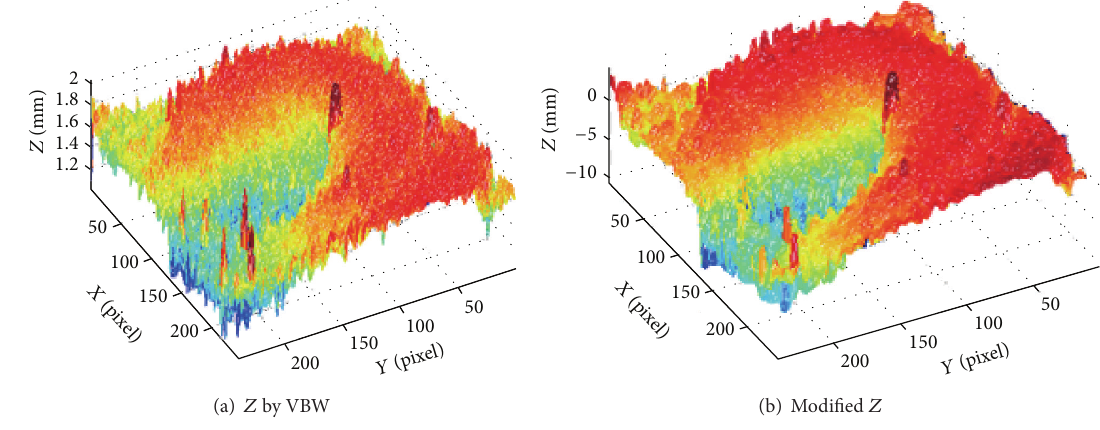
Figure 17: Result for endoscope